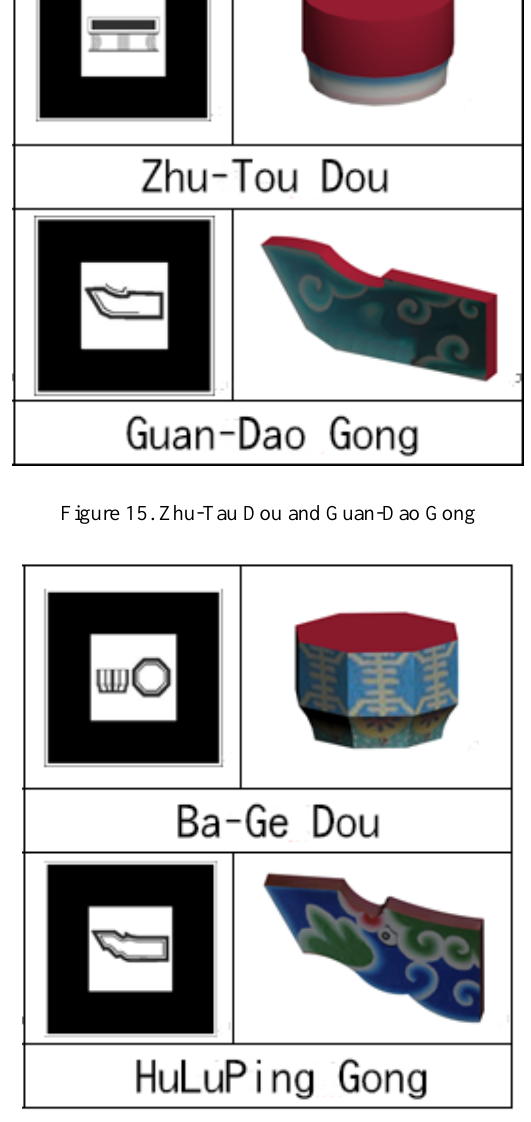
Figure 16. Ba-Ge Dou and HuLuPing